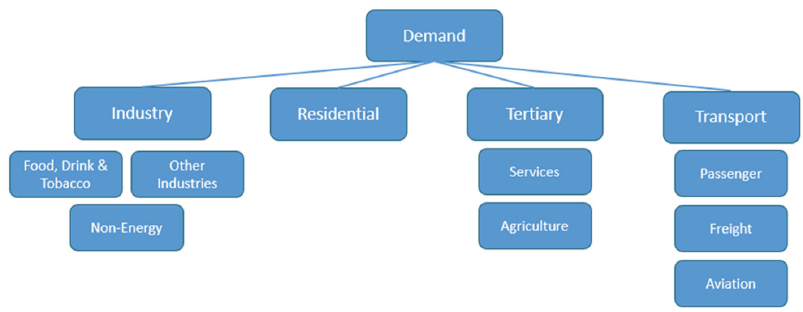
Figure 2 . Sectoral coverage of E3 ‐ ISL energy system model [22] .